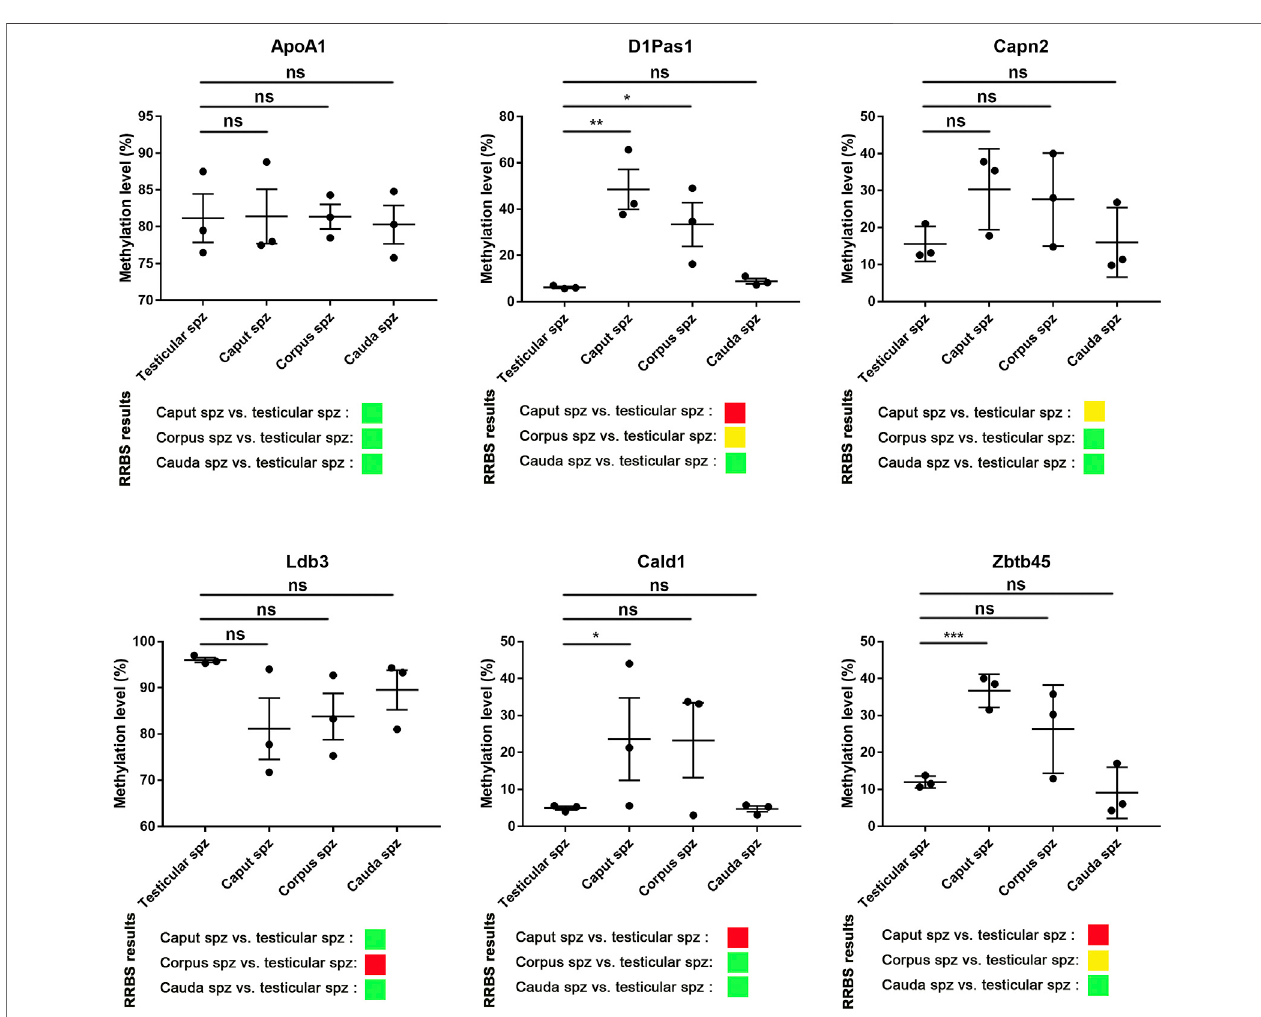
FIGURE4| Pyrosequencingvalidation ofRRBSdata.SixspermaticDNAlocithatexhibitedsigni fi cantmethylationchangesduring post-testicular maturation were validated by pyrosequencing. For each locus, 3 samples of testicular, caput , corpus , and cauda spermatozoa were used. For comparison, differential methylation pro fi les obtained by RRBS are shown. Green, yellow, and red colors represent methylation changes of < 25%, 25 – 50%, and > 50%, respectively. *, **, and ** represent signi fi cant differences p < 0.05, < 0.005, and < 0.001 respectively.